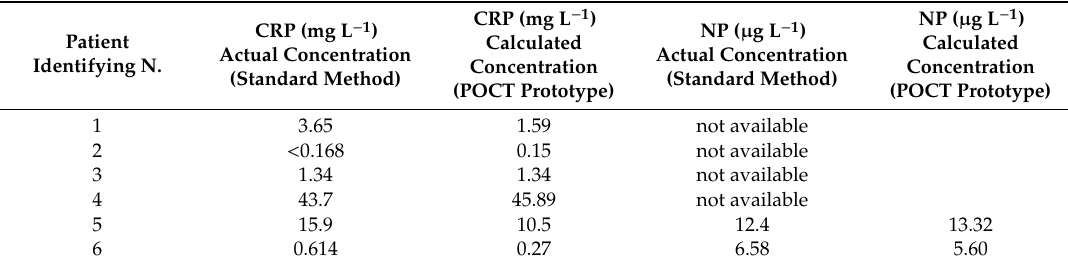
Table 3. Levels of CRP and NP in six septic patients, measured in hospital and with the POCT-prototype described in this paper.